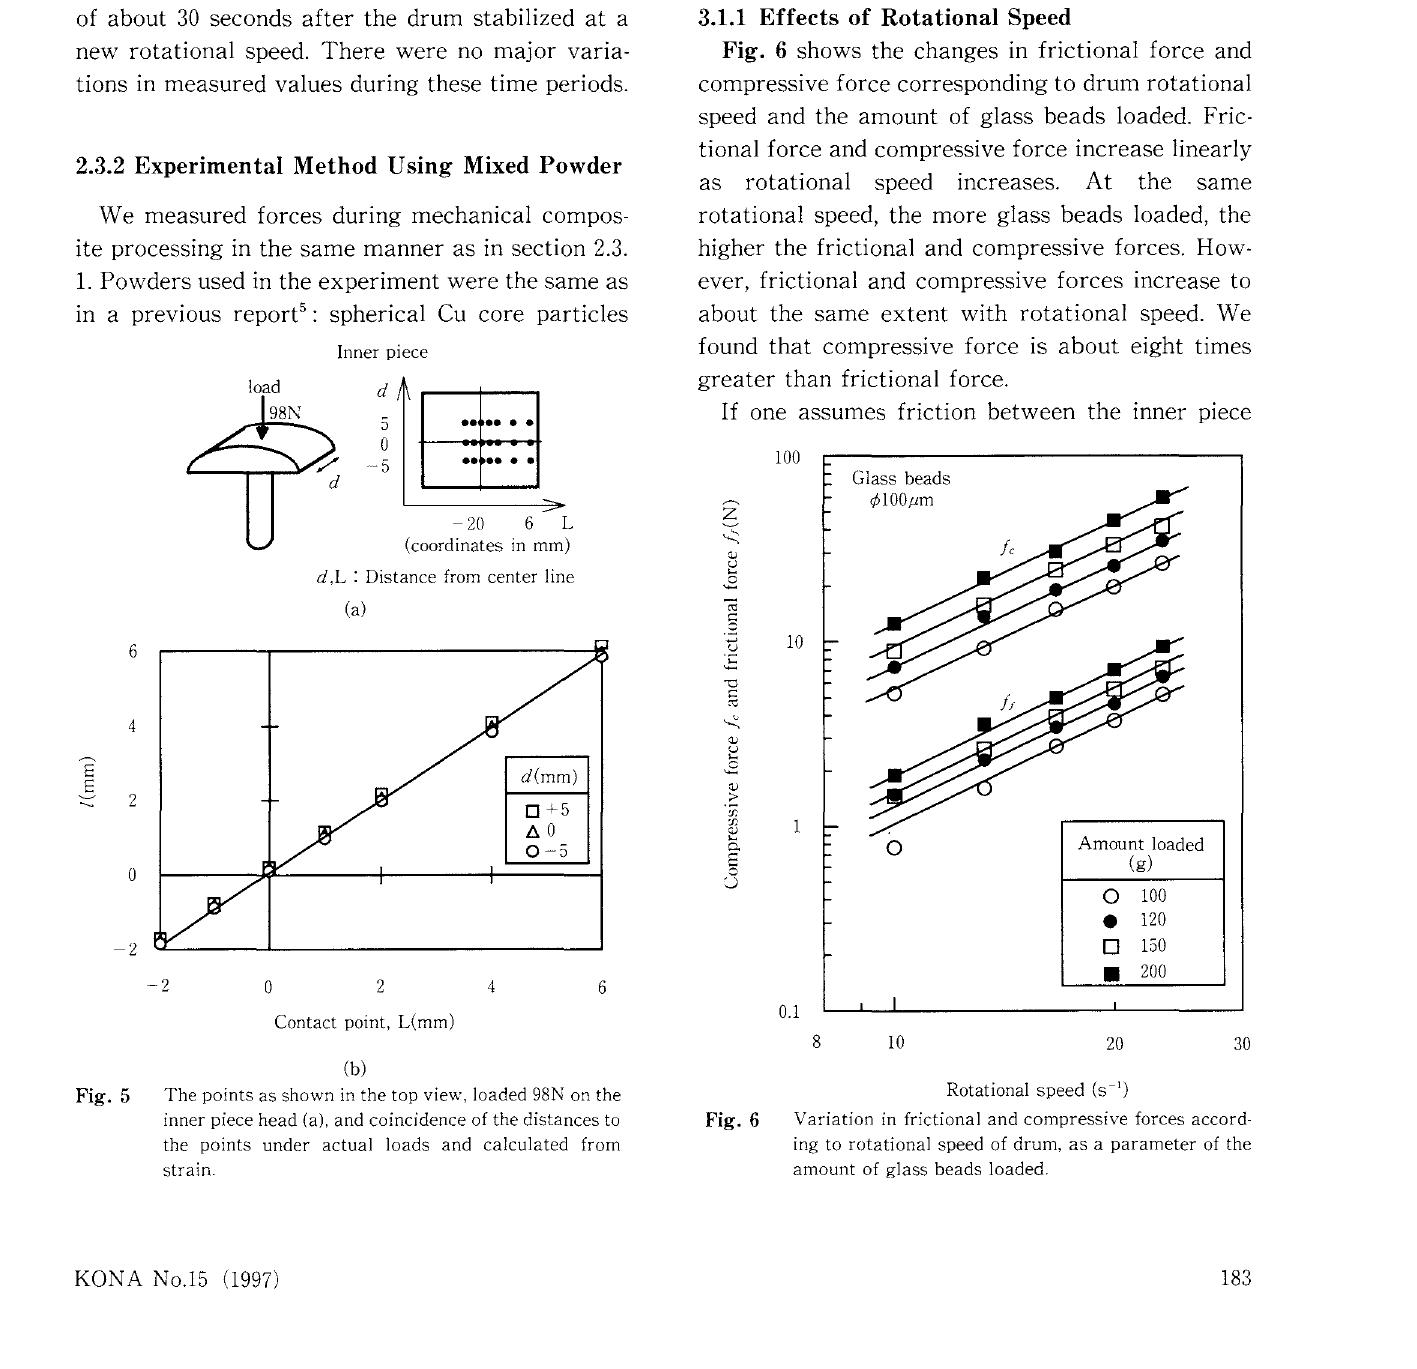
Variation in frictional and compressive forces accord ing to rotational speed of drum. as a parameter of the amount of glass beads